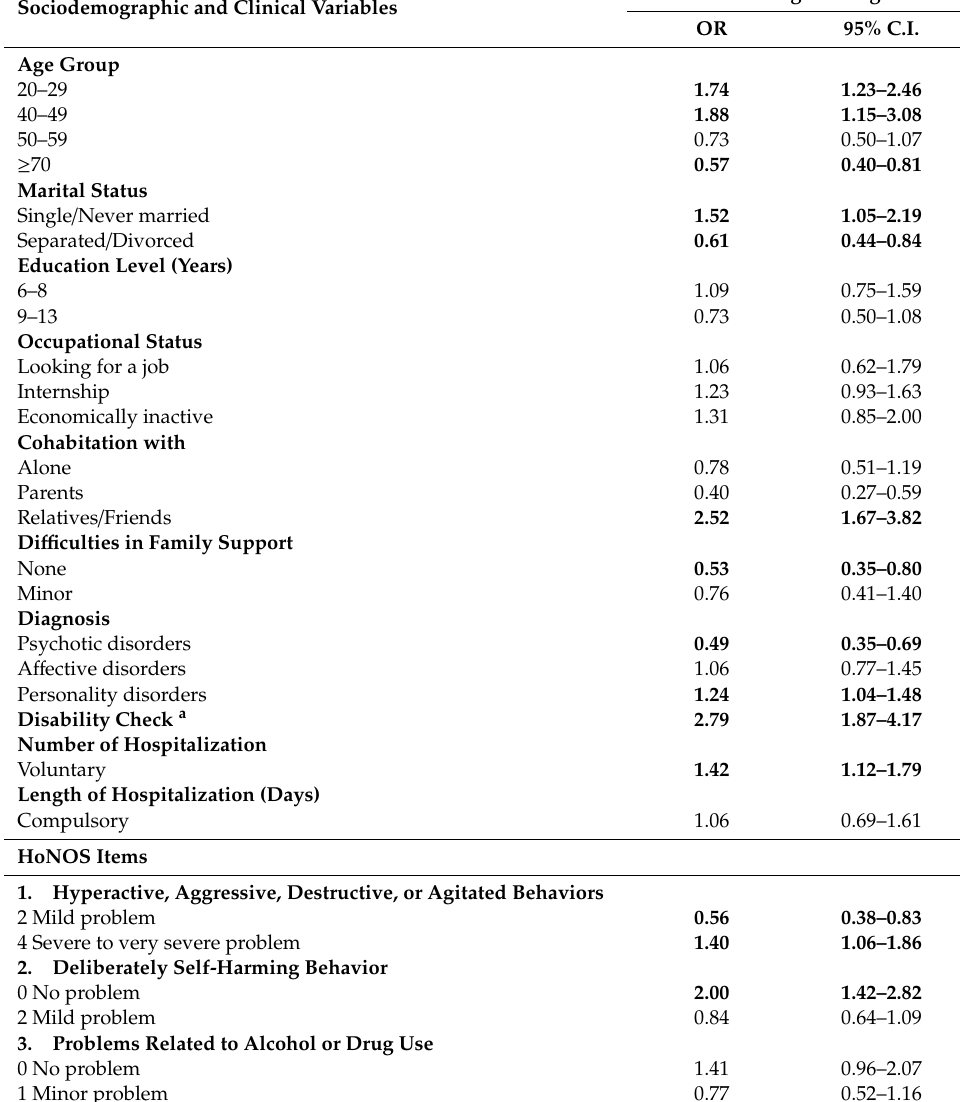
Table 3. Association between sociodemographic and clinical variables, and Health of the Nation Outcome Scale (HoNOS) items in relation to the allocation of Individual Health Budget (IHB). Only variables identified with a feature selection algorithm ( N = 60) were considered in the analysis. Odds ratios (OR) and 95% confidence intervals (95% C.I.) were estimated by means of multivariate logistic regression analysis. The Individual Health Budget group (IHB) was used as reference category (OR = 1.0). Significant ORs are highlighted in